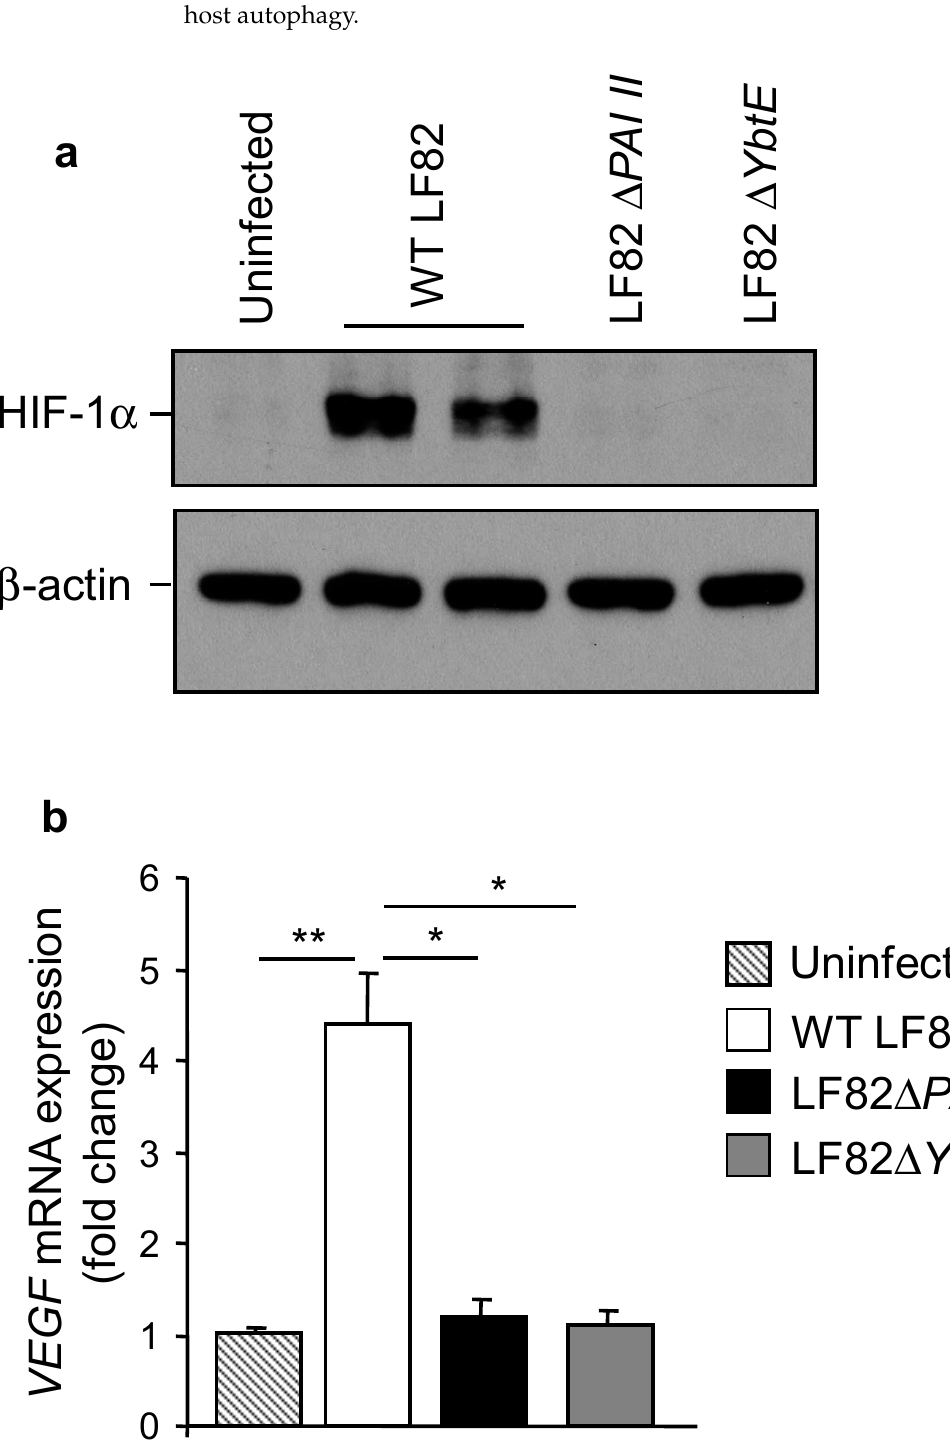
Figure 4. Yersiniabactin is required for AIEC LF82-induced HIF-1 α expression and activation in IECs. ( a , b ) T84 cells were infected with the WT LF82 strain or with one of the mutants AIEC ∆ PAI II and AIEC ∆ YbtE for 3 h, washed, and incubated with gentamicin for 3 h. ( a ) HIF-1 α expression was analyzed by Western blot. ( b ) VEGF mRNA expression level was assessed by qRT-PCR. Data are means ± SEM of six replicates and are representative of two independent experiments. * p < 0.05, ** p ≤ 0.01 by one-way Anova, followed by a post-test Bonferroni.